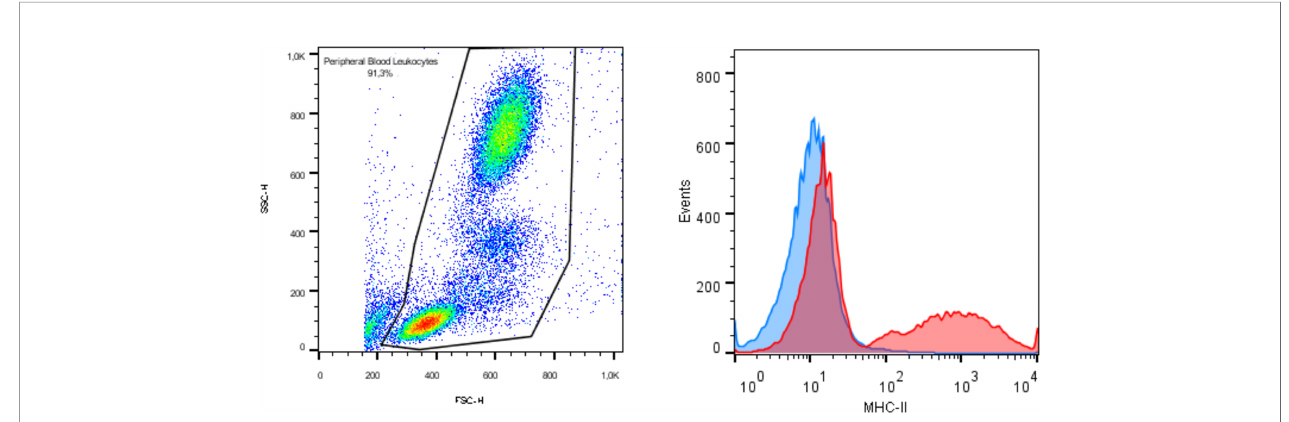
FIGURE 1 | Immunophenotyping by fl ow cytometry exhibiting expression of MHC class II in equine peripheral blood as positive